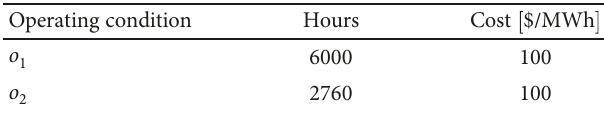
Table 10: Time for each operating condition and weighting factor for each operating condition not satisfying clean energy ’ s goal.